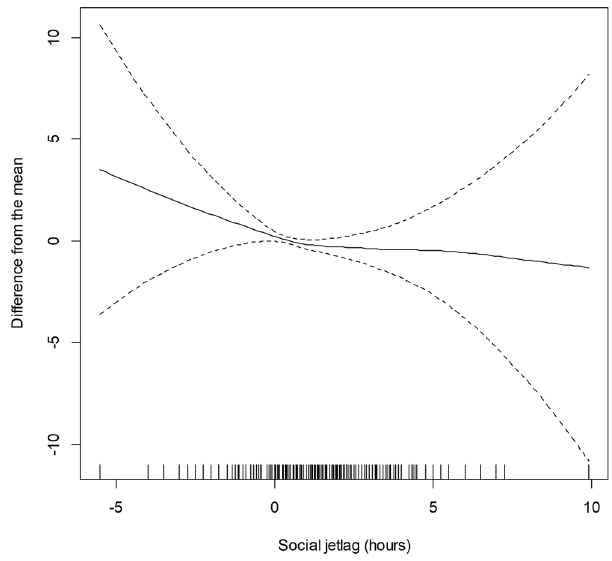
Figure 2. Nonparametric association between social jetlag (hours) and standardized estimated glomerular filtration rate (mL/min/1.73 m 2 ) that was adjusted for age, sex, marital status, occupation, weekly working hours, smoking, drinking, hypertension, diabetes, obesity, and self-rated health. Note that the y-axis is "difference from the mean", not the actual value of estimated glomerular filtration rate.